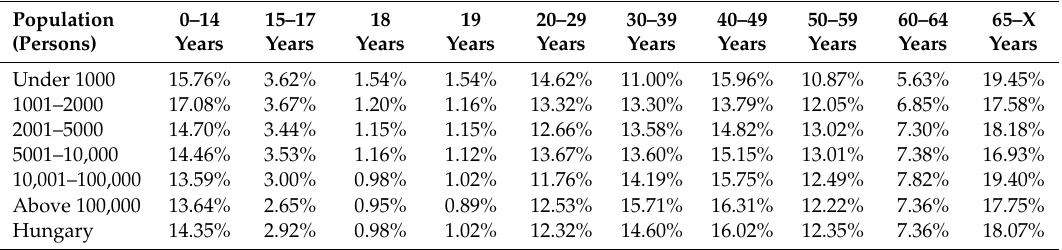
Table 3. Age groups in the target area and in Hungary by population